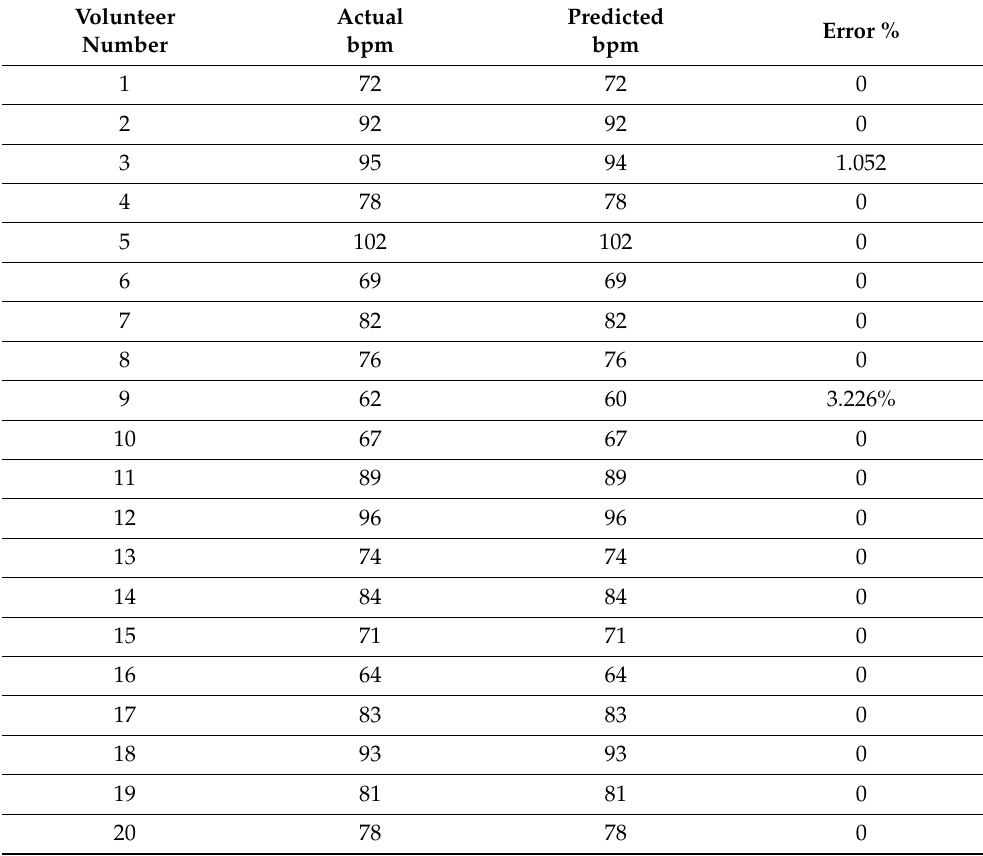
Table 4. The results of the proposed